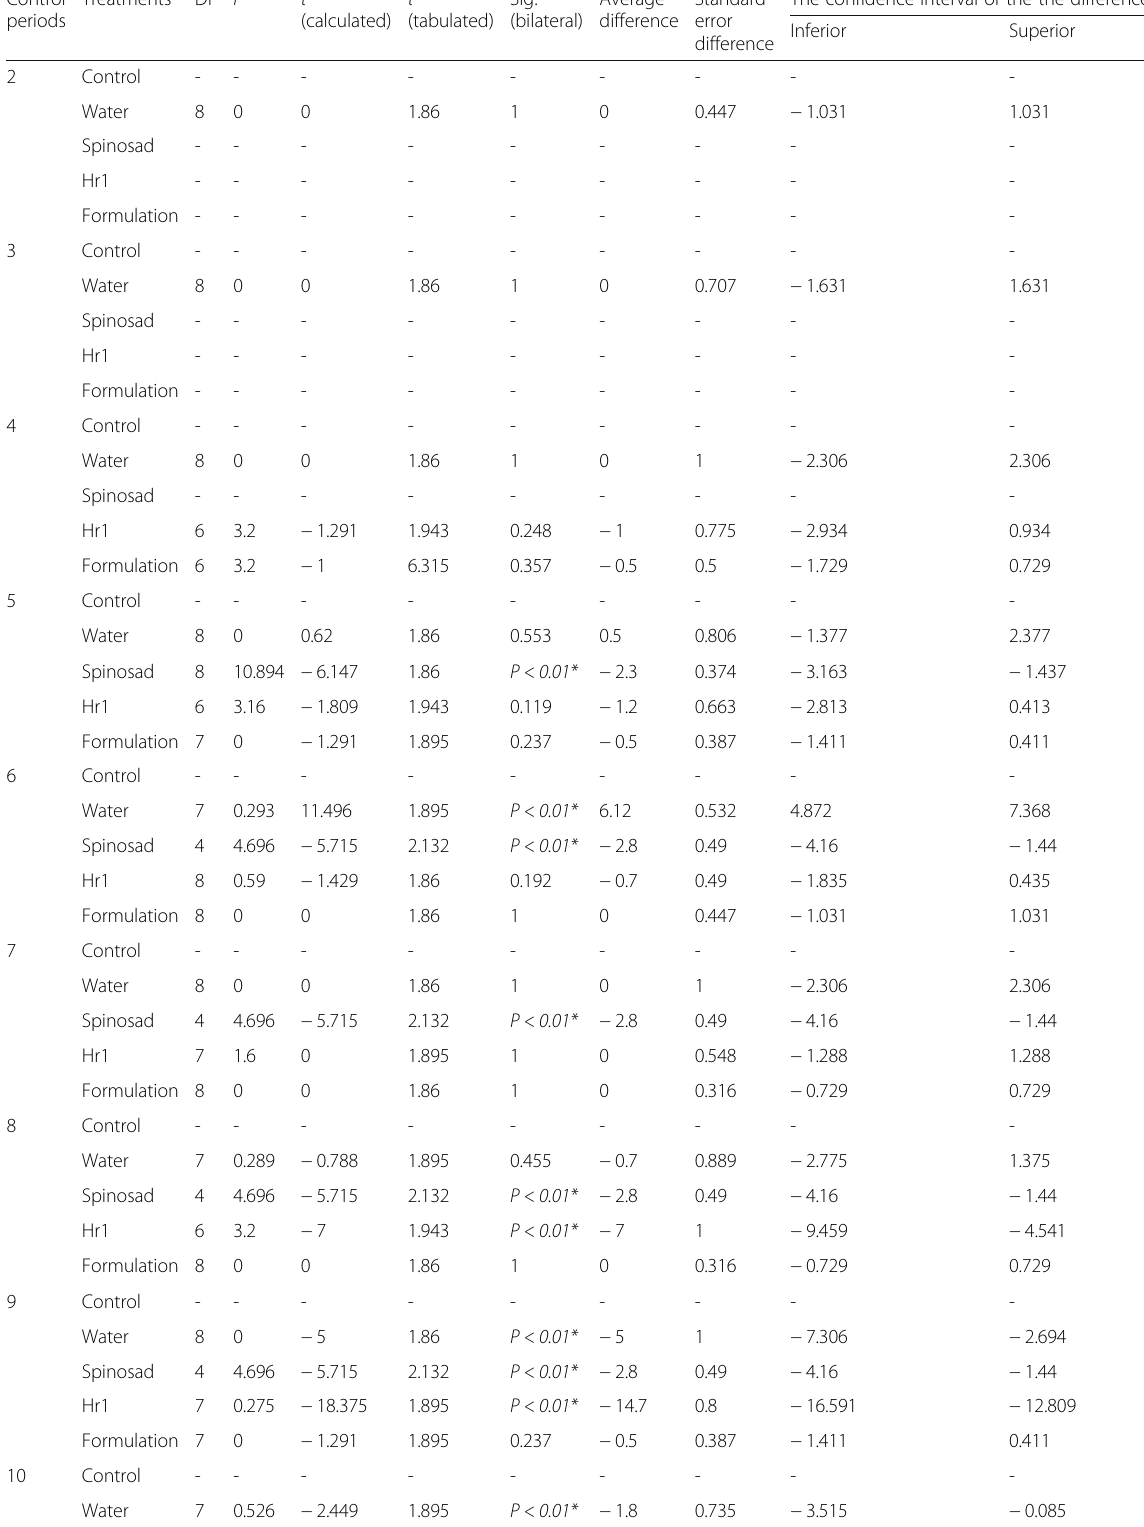
Table 4 Student test for independent samples ( P ≤ 0.05, n = 5) to compare the averages of the different treatments before and after rain simulation Control Treatments DF F periods